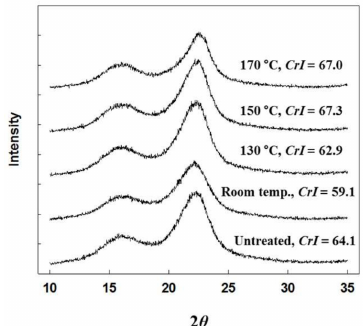
The diffraction patterns and CrI s (crystallinity indices) of untreated and treated Miscanthus × giganteous at different reaction temperatures. Reaction conditions: 60 min reaction time, 40% ethanol concentration and L/S =